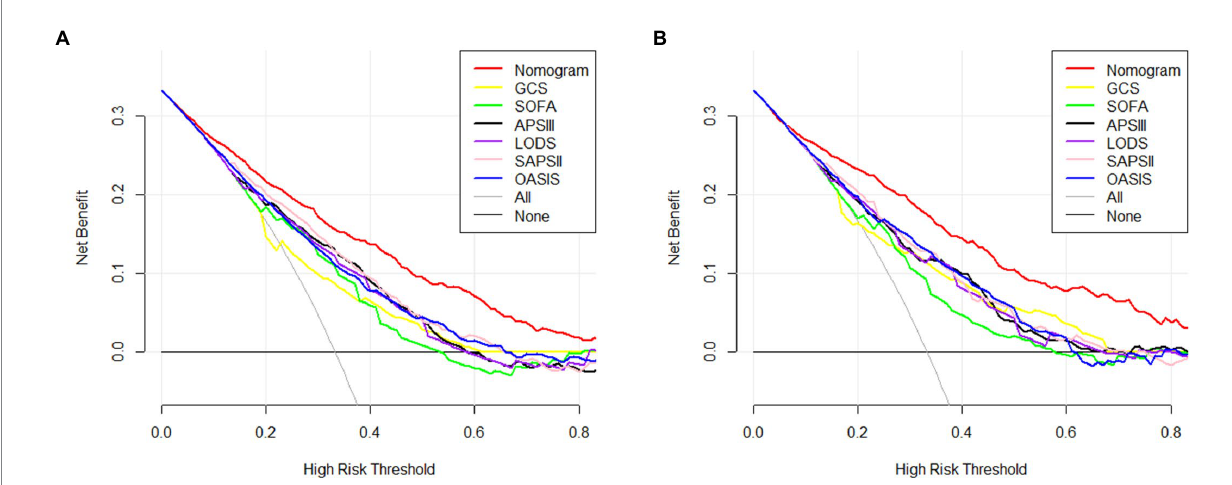
FIGURE 5 The decision curves analysis of the constructed nomogram and models based on common clinical scoring systems in the training set (A) and validation set (B) . In both sets, the red line represents the results of constructed nomogram and the best performance was achieved by our nomogram. GCS, Glasgow coma score; SOFA, sequential organ failure assessment; APS III, acute physiology score III; LODS, logistic organ dysfunction system; SAPS II, simplified acute physiology score II; OASIS, oxford acute severity of illness